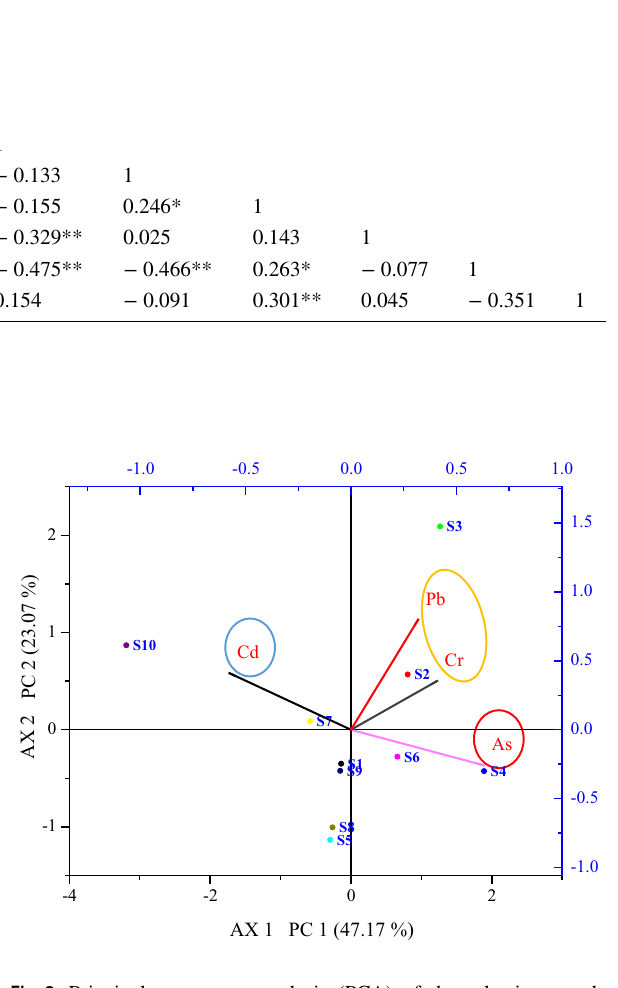
Fig. 2 Principal component analysis (PCA) of the selective metals along the study area (Noakhali District, the high loading of 46.44%, whereas Pb controlled over PC 2 with the high loading of 51.12%. Also, the components were plotted associated with the sites which response values were related to the components. We observed that the corre- sponded value of the metal components in the PCA plot was greater than 0.000 except Cd. Meanwhile, As and Pb were exhibited the significant variance; therefore, axis 1 might be considered to be influenced by anthropogenic activi- ties. Components Pb and Cr confined in the first quadrant, Cd was in second quadrant, and As ran in fourth quadrant.